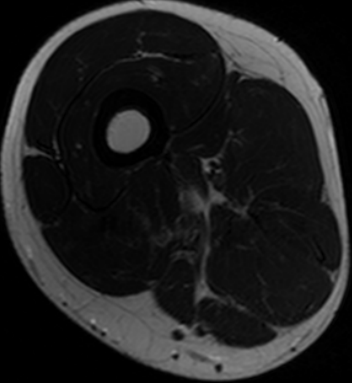
Fig. 10: Slice 12 of imported MR data.